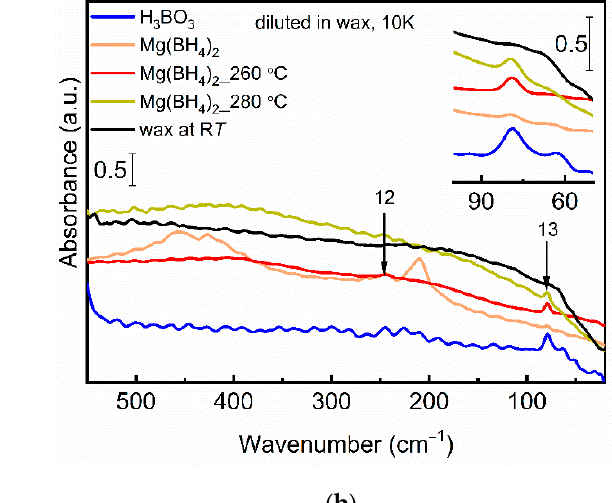
Figure 2. PXRD profiles of as received Mg(BH 4 ) 2 and the samples decomposed at various tempera- tures. The pattern of as received Mg(BH 4 ) 2 corresponds to the porous γ -phase, the pattern recorded after the 240 °C isotherm resembles one of the high temperature phases [20].